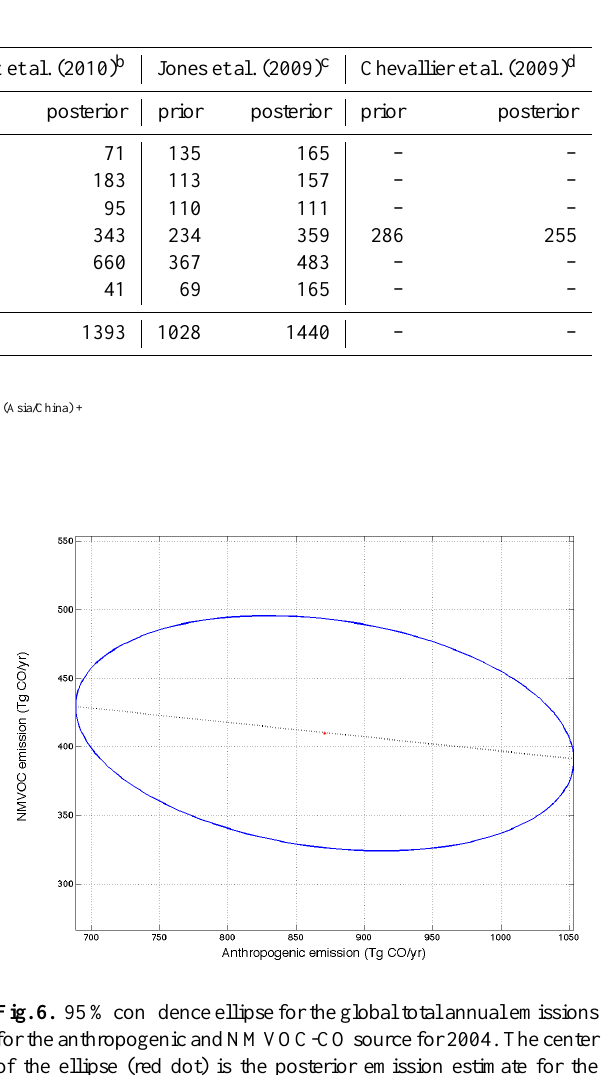
Table 3. Comparison of prior (left columns) and posterior (right columns) continental emission estimates for 2004 of this study with four recent studies for the same year. Numbers are the sum of anthropogenic, biomass burning and natural emissions given in TgCOyr − 1 . Prior inventories and assimilated datasets are given with footnotes.